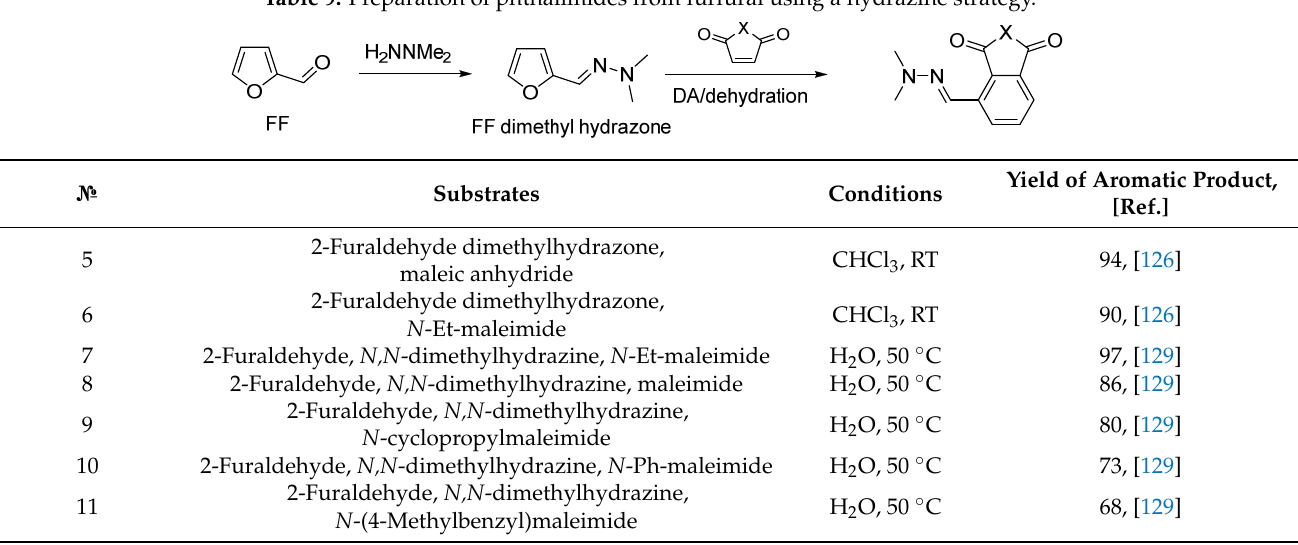
Table 9. Preparation of phthalimides from furfural using a hydrazine strategy.